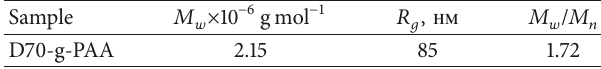
Table 1: Molecular parameters of polymer-nanocarrier.